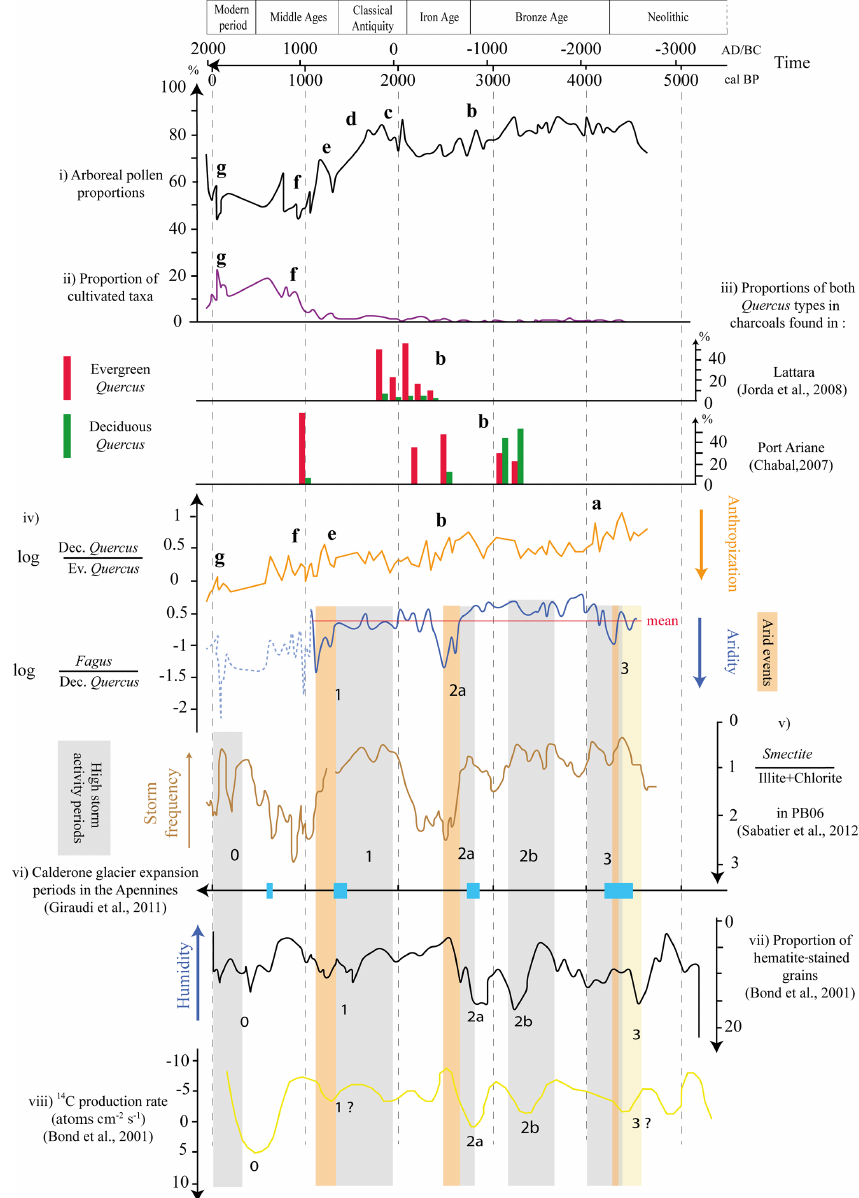
Figure 3. Comparison of the pollen data from the core PB06 and EG08 with anthracological and climatic data. Orange shaded bars represent arid events and grey shaded bars represent high storm activity periods: (i) arboreal pollen proportions; (ii) proportion of cultivated taxa; (iii) proportions of both Quercus type charcoals in Lattara and Port Ariane archeological sites; (iv) logarithm of deciduous / evergreen Quer- cus (orange) and Fagus / deciduous Quercus (blue) ratios (after ∼ 1100calBP (10th century) the Fagus / deciduous Quercus ratio (dotted light blue line) cannot be interpreted in terms of climate fluctuations because of the strong human influence); (v) smectite / illite + chlorite ratio in the core PB06 (Sabatier et al., 2012); (vi) Calderone glacier expansion periods in the Apennines (the width of each blue box rep- resent the estimated time during which the glacier expand (Giraudi et al., 2011)); (vii) proportion of hematite-stained grains in the cores MC-52/VM29-191 in the North Atlantic (Bond et al., 2001); (viii) 14 C production rate (Bond et al., 2001).